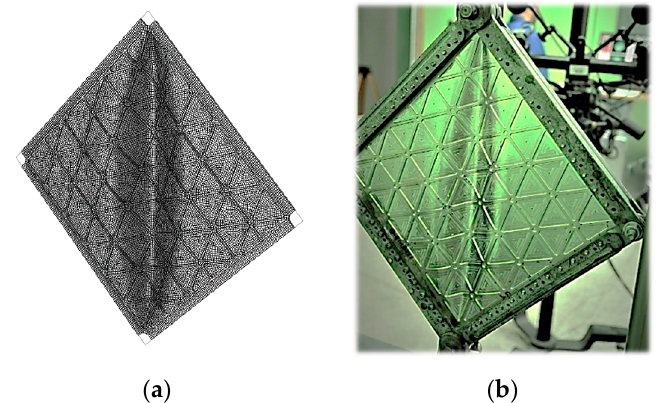
Figure 12. Qualitative comparison of the deflection field at the maximum load. ( a ) The numerical result, ( b ) the experimental result.